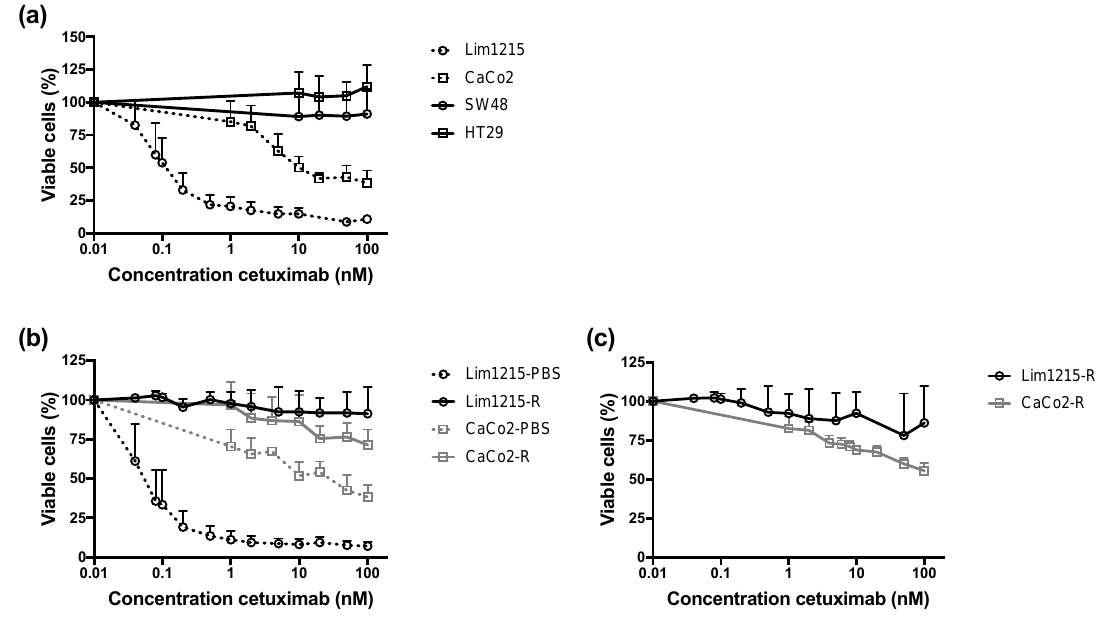
Figure 1. Sensitivity to cetuximab treatment. ( a ) Dose–response curves for RAS wild-type colorectal cancer (CRC) cell lines after cetuximab treatment (168 h). Two out of four CRC cell lines (i.e., SW48 and HT29) were considered as intrinsically resistant to cetuximab. Cetuximab-sensitive CRC cell lines (i.e., Lim1215 and CaCo2) were used to generate isogenic cell lines with acquired cetuximab resistance. ( b ) Dose–response curves for isogenic CRC cell lines with acquired cetuximab resistance (Lim1215-R and CaCo2-R) and cetuximab-sensitive (Lim1215-PBS and CaCo2-PBS) CRC cell lines. ( c ) Dose–response curves for the CRC cell lines with acquired cetuximab resistance after 6 weeks of culture in drug-free medium, followed by cetuximab treatment for 168 h. This graph represents two independent experiments executed in threefold.